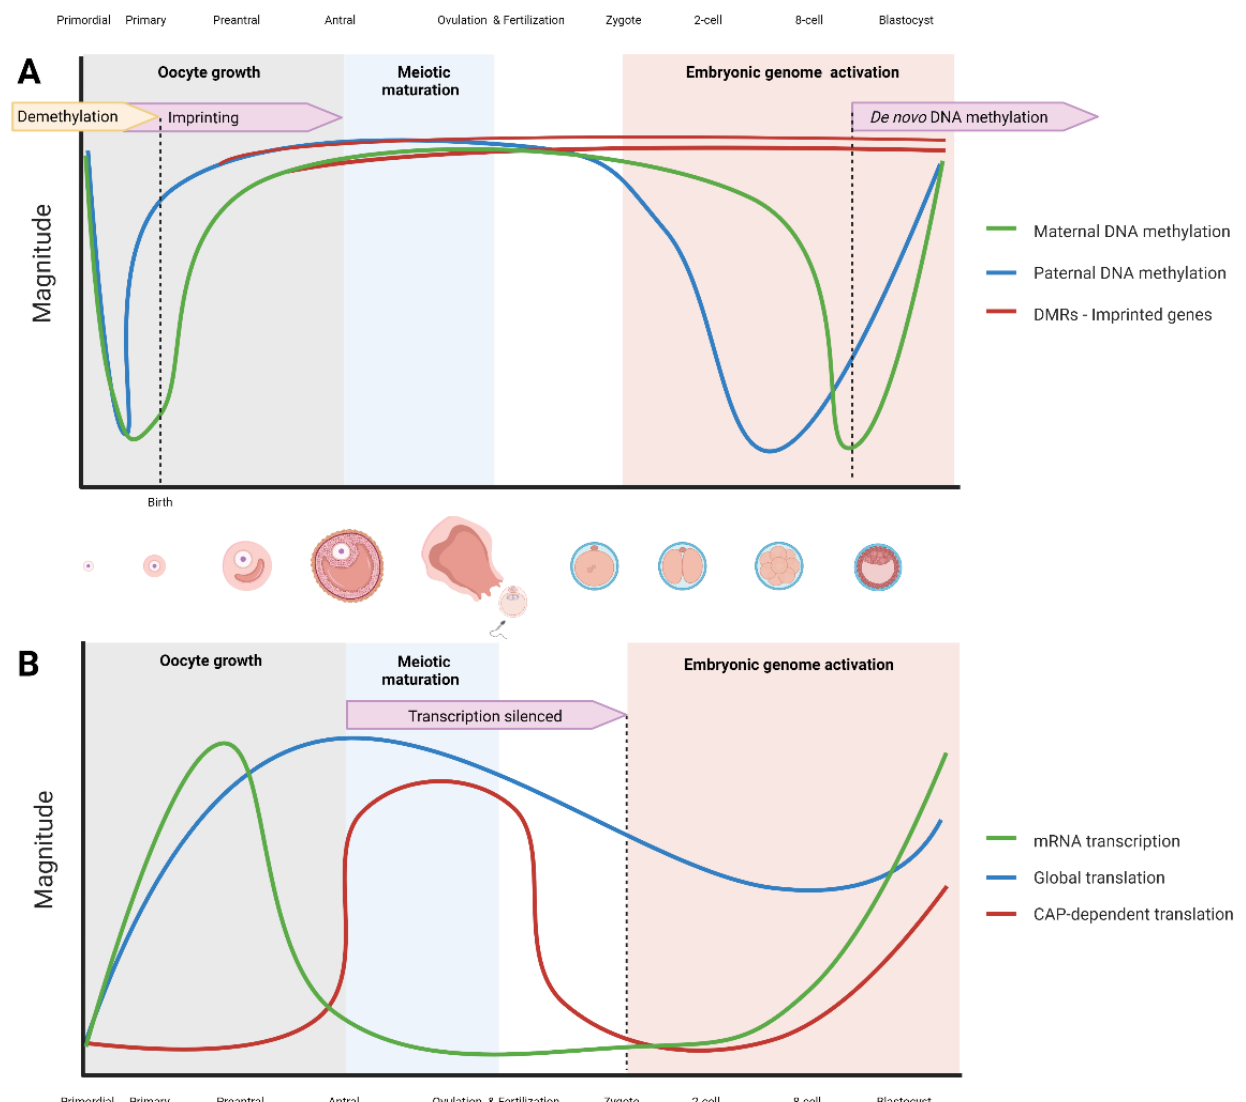
Figure 2. Dynamic DNA methylation and protein translation changes in human oogenesis and early embryogenesis: ( A ) Prenatal DNA demethylation in primordial germ cells (PGC) is followed by de novo DNA methylation, which occurs earlier in males than females. Genomic imprinting loci consisting of DMR (differentially methylated regions) maintain their methylation status despite the important genome-wide DNA demethylation in pre-implantation embryos [1]. ( B ) Oocytes are transcriptionally active during oocyte growth with rapid decline and silencing throughout meiotic maturation [2]. According to the new evidence human embryonic genome activation is initiated at the zygotic stage, but the transcriptional activity remains low until the 8-cell stage [3]. Correct regulation of CAP-dependent translation is a key process in meiotic maturation despite continuous decrease in global translational activity from oocytes to zygotes. The image was created with BioRender.com.